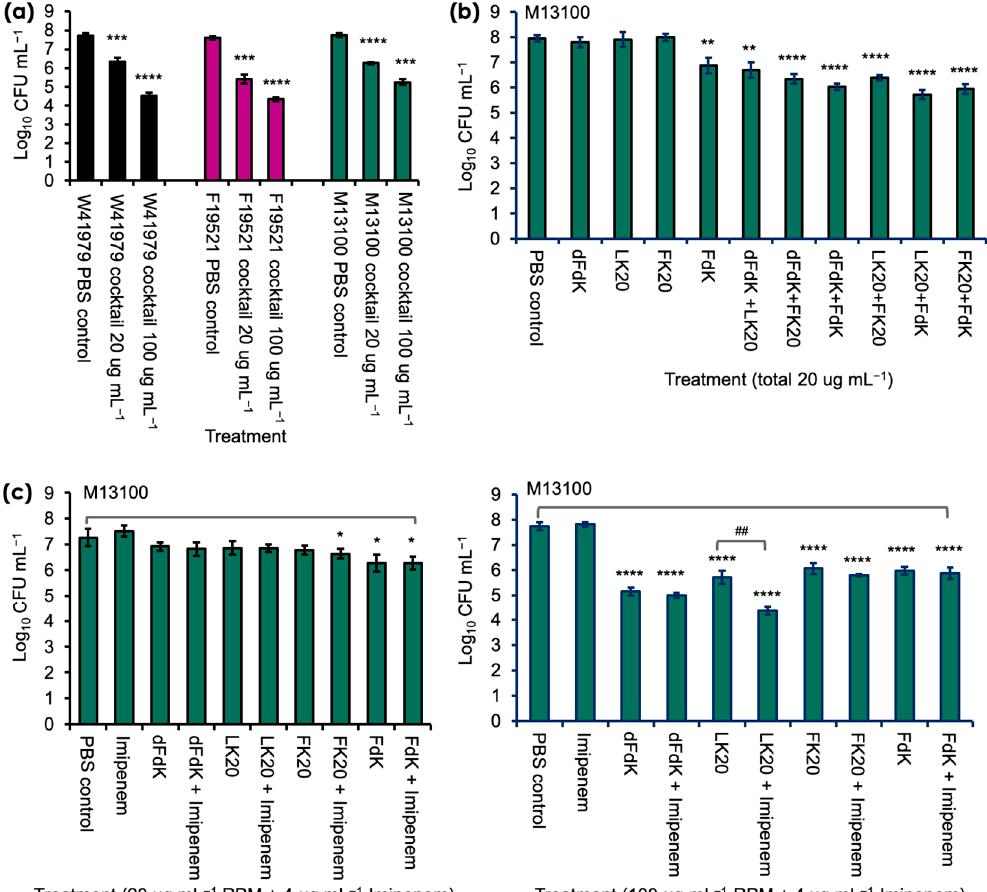
Figure 3. Random peptide mixtures (RPMs) cocktail kills A. baumannii more effectively than individual RPMs and shows additive effects with imipenem. ( a ) The 20 µg mL − 1 cocktail was comprised of 5 µg mL − 1 each of dFDK, LK20, FK20, and FdK whereas the 100 µg mL − 1 cocktail was comprised of 25 µg mL − 1 each of the aforementioned RPM. ( b ) Killing of A. baumannii strain M13100 by individual or cocktail of two RPMs (each RPM at 10 µg mL − 1 ). ( c ) Killing of M13100 by RPM and imipenem cocktails. Error bars represent SD for n = 3 of a typical experiment performed independently three times. * p < 0.05, ** p < 0.01, *** p < 0.001, and **** p < 0.0001 significance compared to respective phosphate buffered saline (PBS) control as determined by the Student’s t -test. ## p < 0.01 significance compared to respective LK20 against LK20 + imipenem as determined by the Student’s t -test.